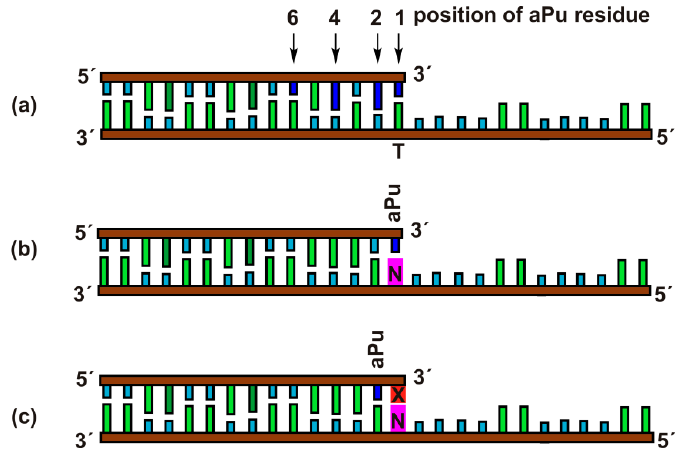
Figure 2. Schematic structures of DNA duplexes Exo-aPu j /T ( a ), Exo-aPu 1 /N ( b ), and Exo-aPu 2 -X/N ( c ) used as substrates and ligands of APE1.